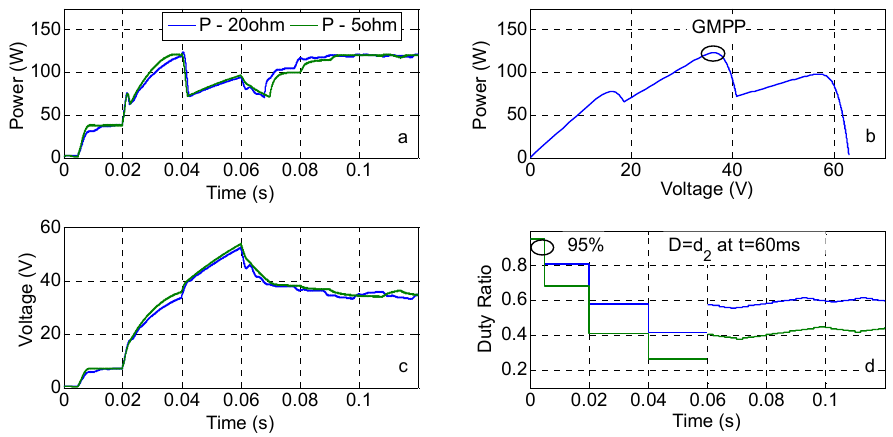
Figure 13. Case 4 and Case 5 ( a ) Voltage; ( b ) Power; ( c ) Duty Ratio; and, ( d ) Current.